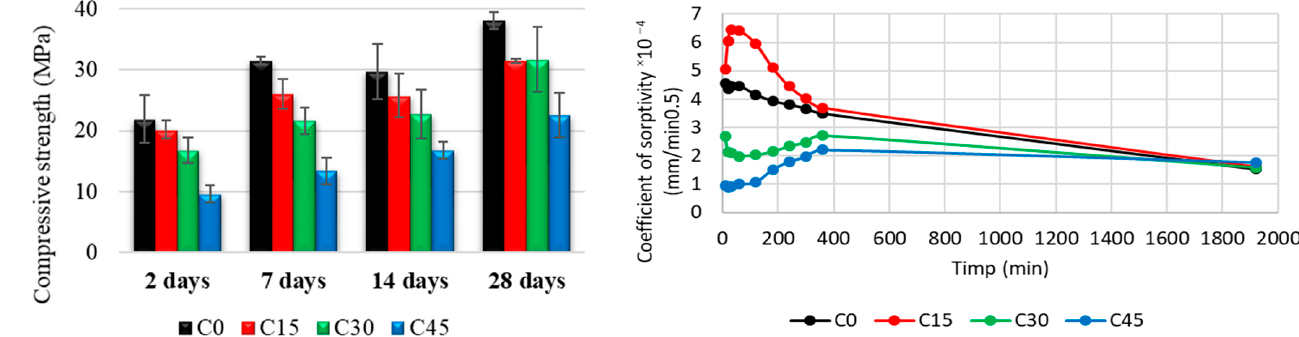
Figure 12. Mechanical compressive strength ( left ) and sorptivity ( right ) of waste containing Portland cement samples.